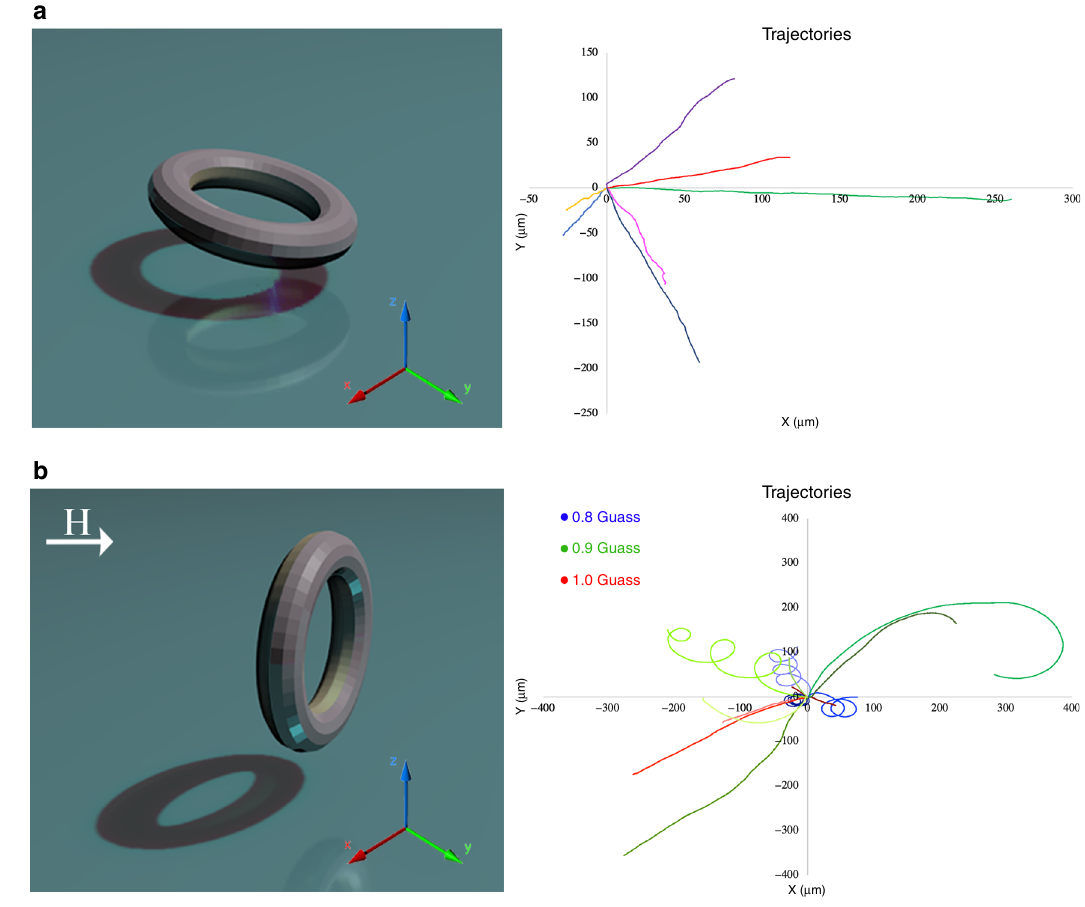
Fig. 2 Swimming trajectories. a Extracted and re-centered trajectories for linearly translating dipped and glazed Janus tori. b Trajectories of vertically oriented tori in an increasing magnetic fi eld. The trajectories change continuously from cyclodial to linear. Blue trajectories are for 0.8 G; green trajectories are for 0.9 G; and red trajectories are for 1.0 G